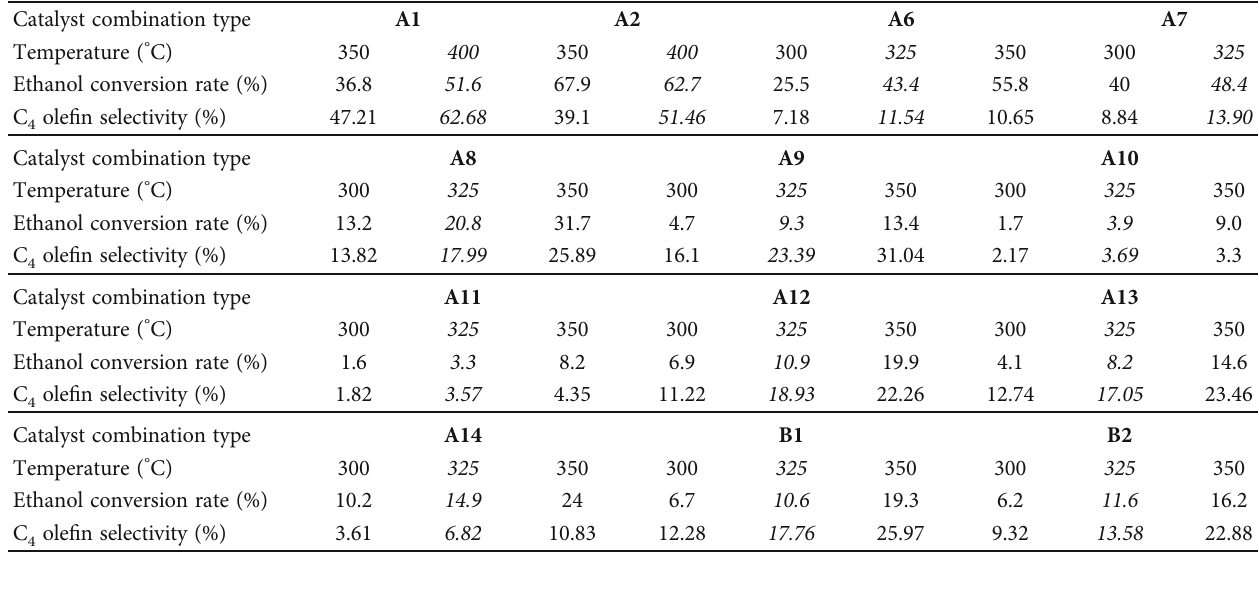
Table 1: Spline interpolation to patch missing data.